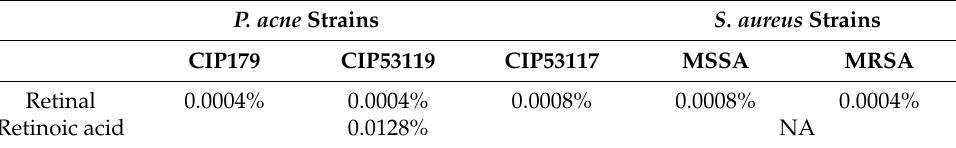
Table 2. Minimum inhibitory concentration (MIC) of retinoids against various strains of Gram- positive bacteria [106,107]. Methicillin-sensitive S. aureus (MSSA) and methicillin-resistant S. aureus (MSSA). Not active